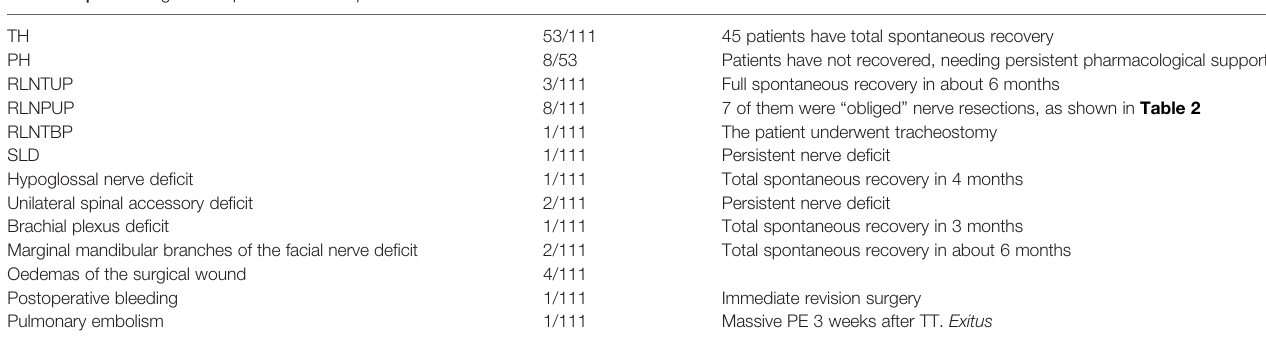
TABLE 3 | Post-surgical complications developed in our series.